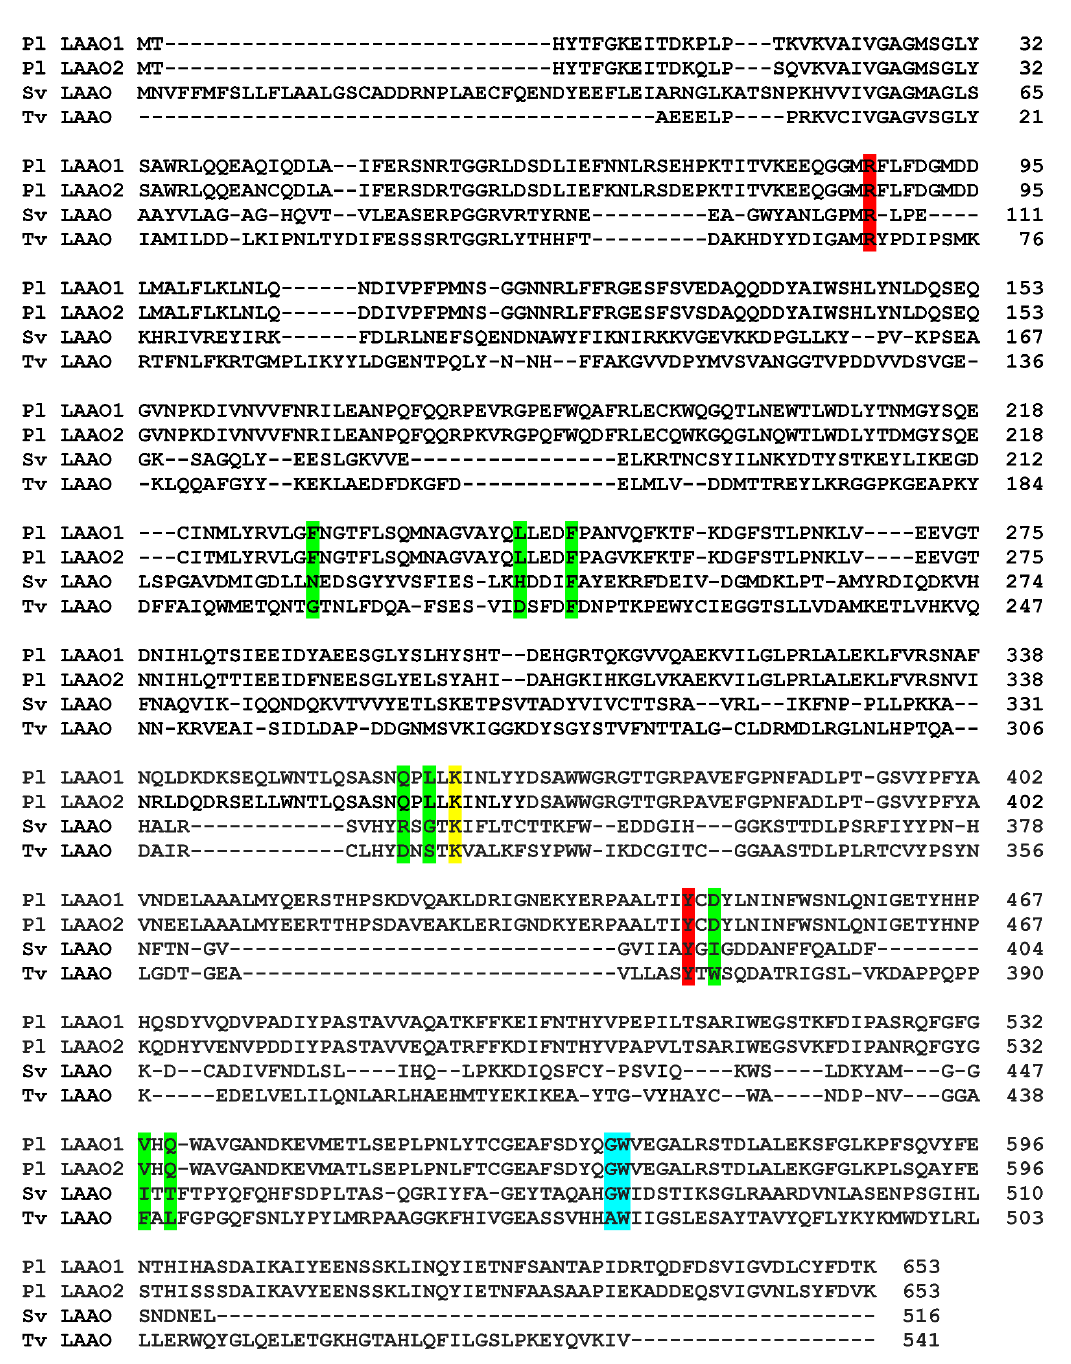
Figure 5. Amino acid sequence alignment of LAAOs. The sequences displayed are P. luteoviolacea CPMOR-1 LAAO (Pl LAAO1) (GenBank: WP_063369592), P. luteoviolacea CPMOR-2 LAAO (Pl LAAO2) (GenBank: KZN49687), SvLAAO (GenBank: CAB71136.), and TvLAAO (UniProt A0A0J9X1X3). Residues in the active site are highlighted. These are residues that interact with the carboxyl group (red) and amino group (cyan) bound to the α -carbon, residues that potentially interact with the amino acid side chain (green), and a residue that stabilizes a water molecule for use in catalysis (yellow). The numbering in this table corresponds to the amino acid numbers in the figures in this paper. It should be noted that the first 18 residues in the SvLAAO sequence comprise a signal sequence that is cleaved during export of the protein outside of the cell. The sequence in PDB 2IID does not include these residues. Therefore, there is an 18-residue difference in the numbering adopted here compared to the numbering in the PDB sequence.